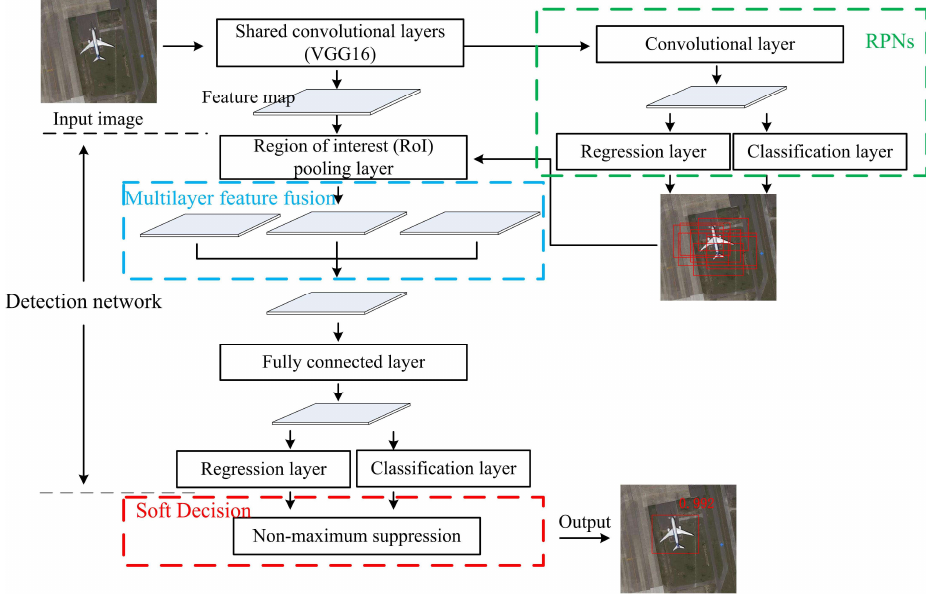
Figure 4. The flowchart of airplane detection method.